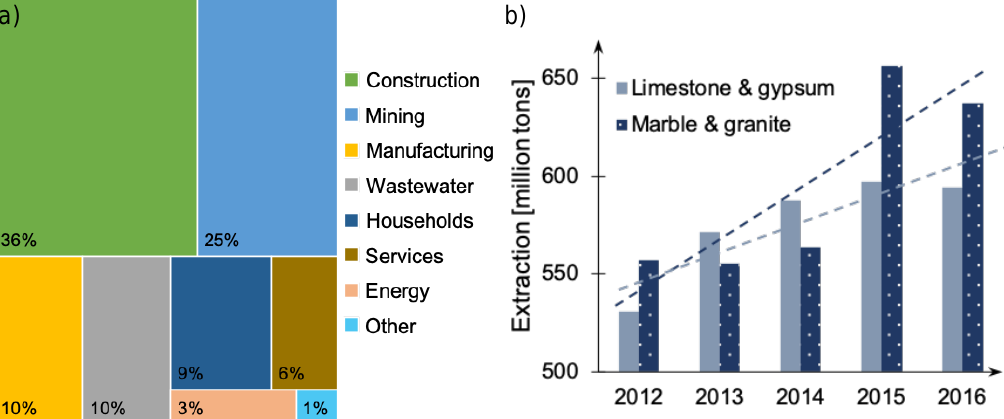
Figure 1. Statistics for twenty-eight European countries (according to https://ec.europa.eu/eurostat): ( a ) waste generation in 2016 by economic activities and households; ( b ) selected materials extraction.